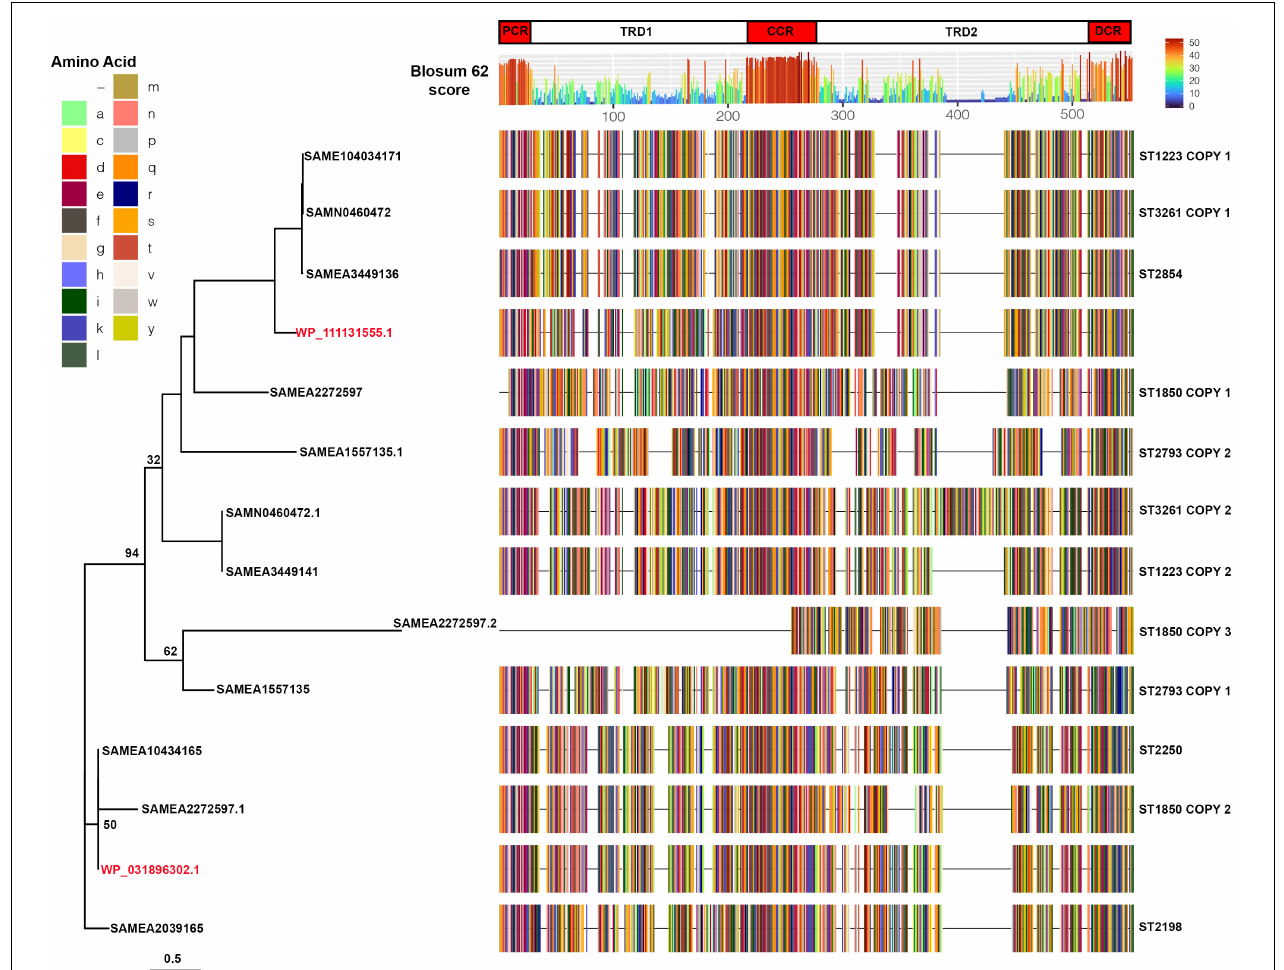
FIGURE 6 | Sequence comparisons of hsdS proteins in S. argenteus strains. Representative sequences of the aligned hsdS proteins from the different S. argenteus STs are shown, colored by amino acid residue as shown in the key. Two S. aureus hsdS protein sequences are shown in red, labeled with their corresponding National Center for Biotechnology Information identifier. Blosum62 homology scores across all the sequences are shown above the alignment, colored as shown in the key. The domains of the hsdS protein are shown above the homology score graph – PCR, proximal conserved region; TRD1 and 2, target recognition domains 1 and 2; CCR, central conserved region; DCR, distal conserved region. The phylogenetic tree to the left shows the sequence relationships. Bootstrap support for the major branches is shown (1,000 bootstraps). The scale shows the average number of substitutions per site.